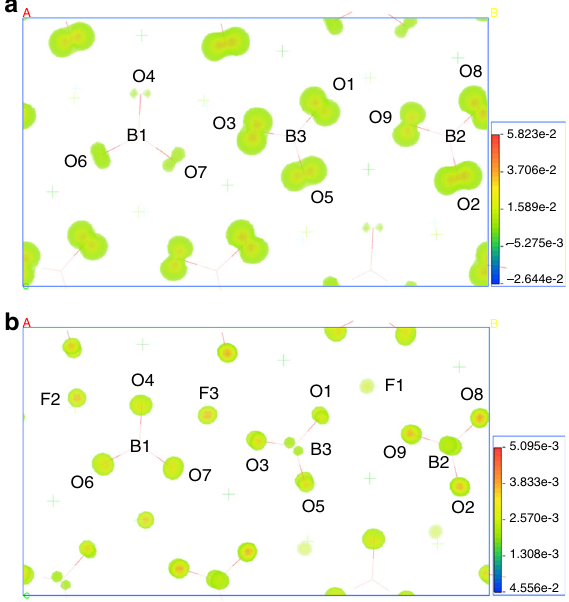
Fig. 8 The second-harmonic generation density analysis of Pna 2 1 - Ba 3 Mg 3 (BO 3 ) 3 F 3 . a The density maps of the occupied orbitals in virtual electron process of the second-harmonic generation tensor d 33 . b The density maps of the unoccupied orbitals in virtual electron process of the second-harmonic generation tensor d 33 of Pna 2 1 -Ba 3 Mg 3 (BO 3 ) 3 F 3 . Isovalue increases from blue to red, and the maximum electron localization function values are scaled to 5.823 × 10 − 2 for occupied orbitals ( a ) and 5.095 × 10 − 2 for unoccupied orbitals ( b ),